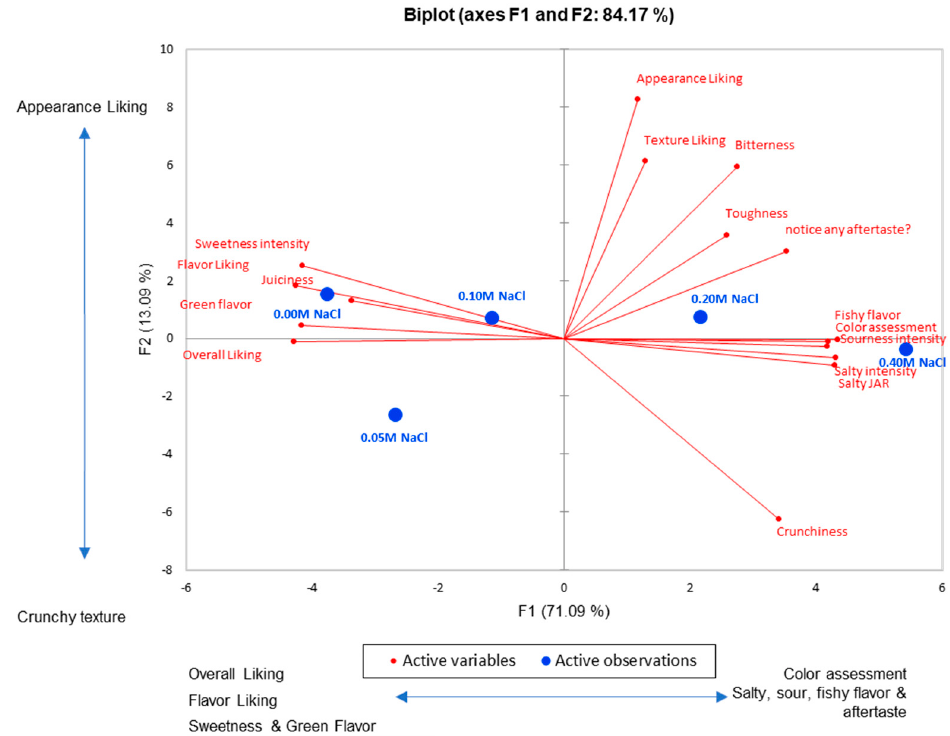
Figure 4. PCA Summary Plot. x -axis = F1 accounts for 71.09% total data variation; y -axis = F2—13.09% data variation. Top positive and negative factor loadings were called out for ease of interpretation.